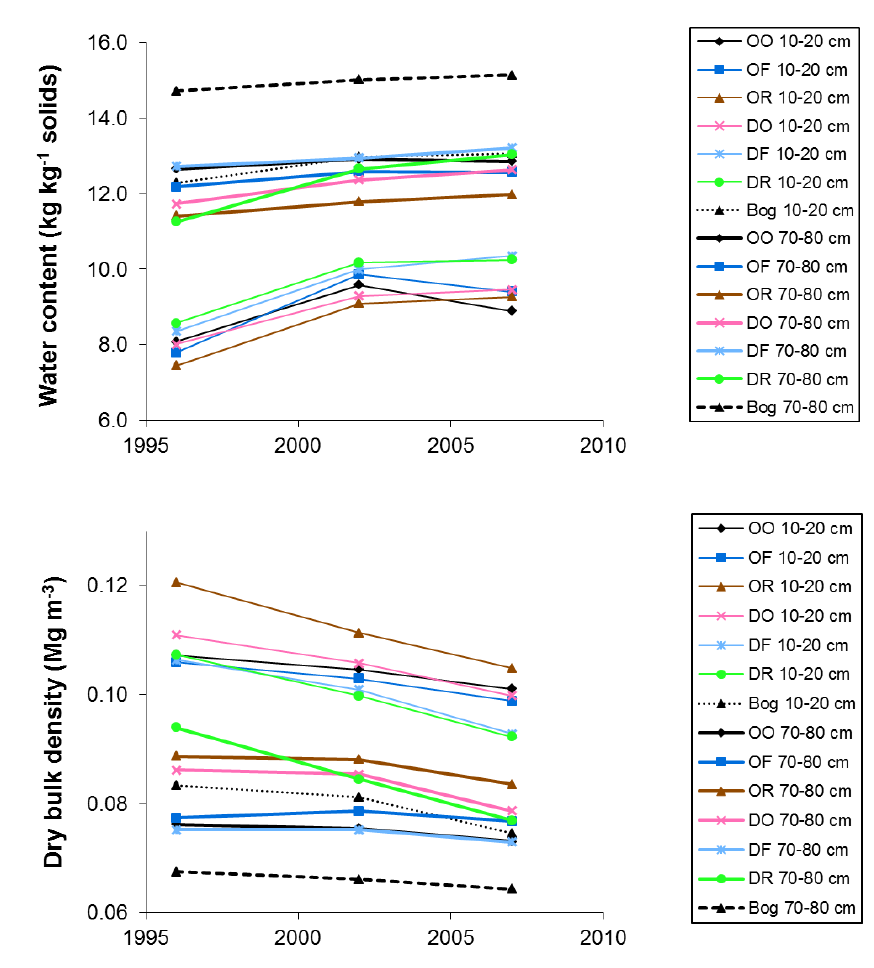
Figure 11. Ten-year change in (a) water content and (b) dry bulk density of peat at two different depths in response to the restoration treatments. Mean values for samples from the adjacent bog are shown for